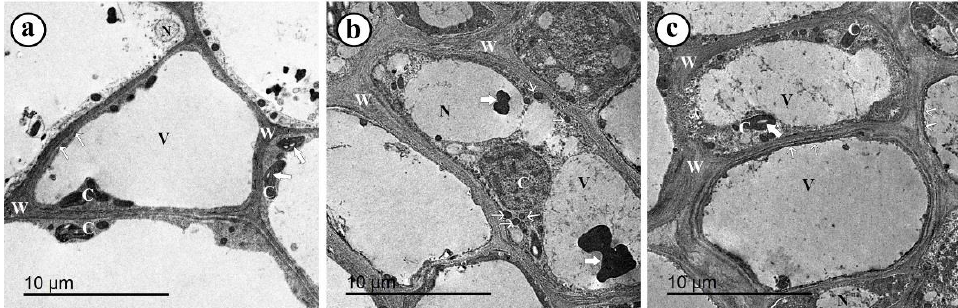
Figure 5. Where ( a ) control plant (uninfected, untreated, and non-mycorrhizal) shows a well-organized and normal cell with a thin cell wall (W) and plasma membranes (short arrows), small nucleus (N), big vacuole (V), and normal chloroplasts (C) containing starch granules (wide arrows) (bar = 10 μm) ; ( b ) infected plant (untreated, and non-mycorrhizal) showing a disorganized cell with a thick cell wall (W), abnormal chloroplast (C), very electron-dense particles (arrowheads), abnormal vacuole (V), and enlarged nucleus (N), and cytoplasmic granulation (bar = 10 μm) ; ( c ) mycorrhizal pea plant, infected with Fusarium wilt and treated with S. viridosporus HH1 showing a well-organized cell enclosed with a very thick cell wall (W) and cell membrane (arrowheads) and contains a normal nucleus (N), normal chloroplast (C) with starch granules (wide arrows), big vacuole (V), and granulated cytoplasm (bar = 10 μm).